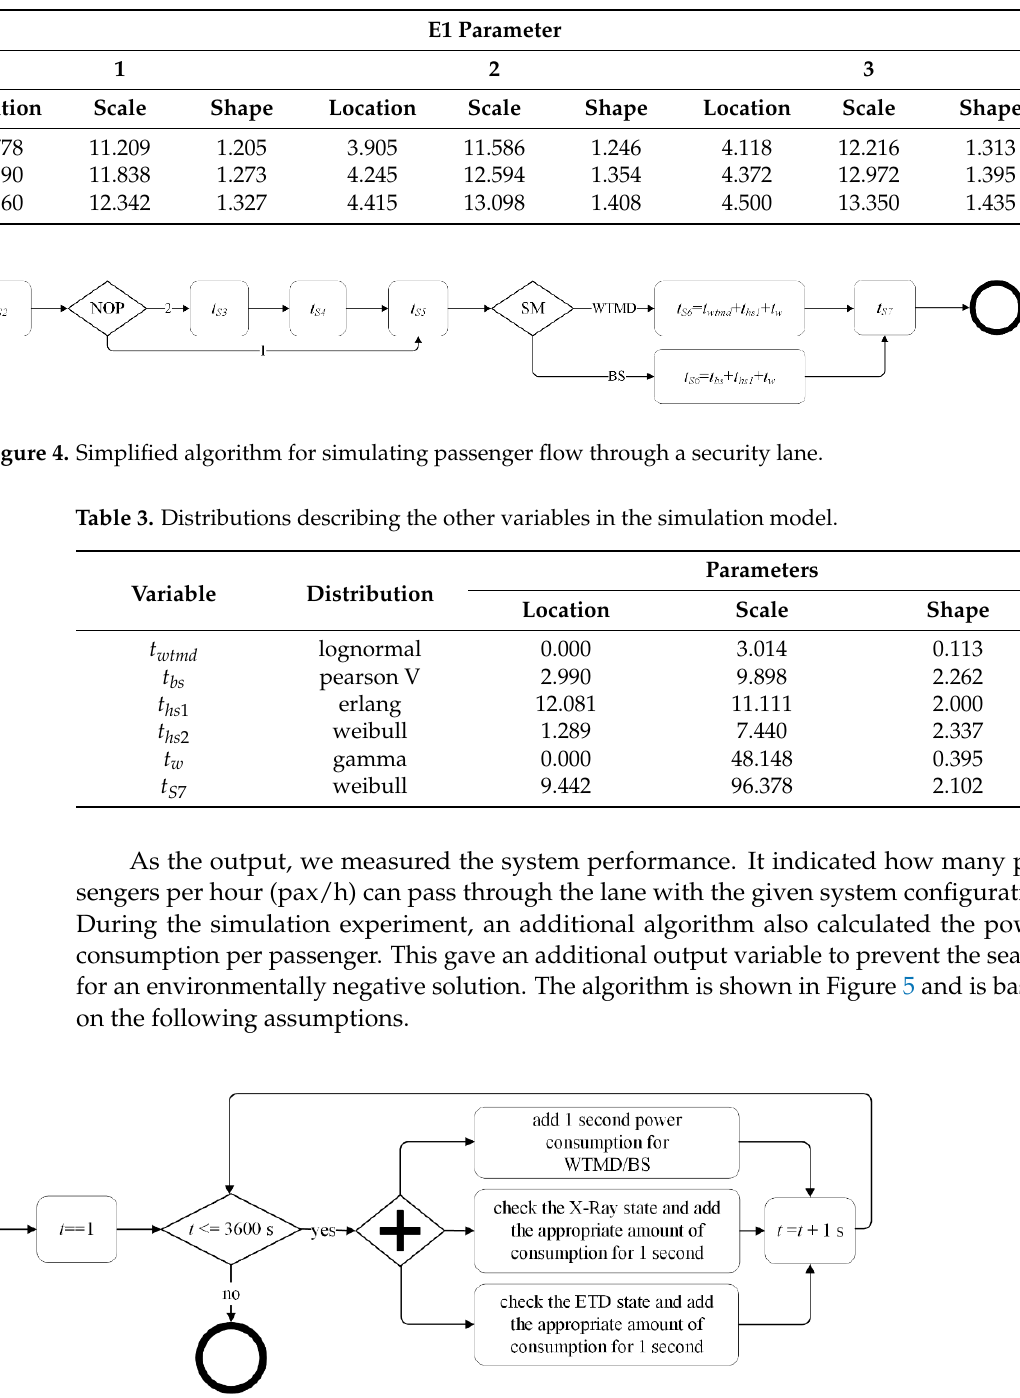
Table 2. Weibull distribution parameters, describing the time, t S 4 , depending on the experience of the second operator conditioned by experience of first operator.